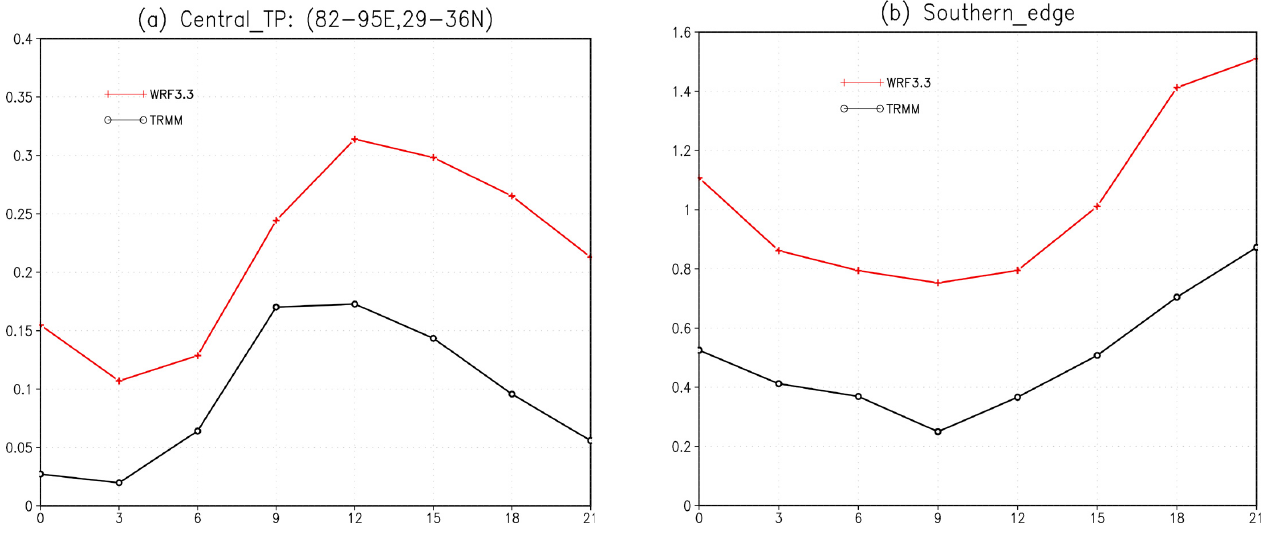
Fig. 4. Diurnal variation in precipitation (mmh − 1 ) averaged over: (a) the central plateau, (b) the southern edge.